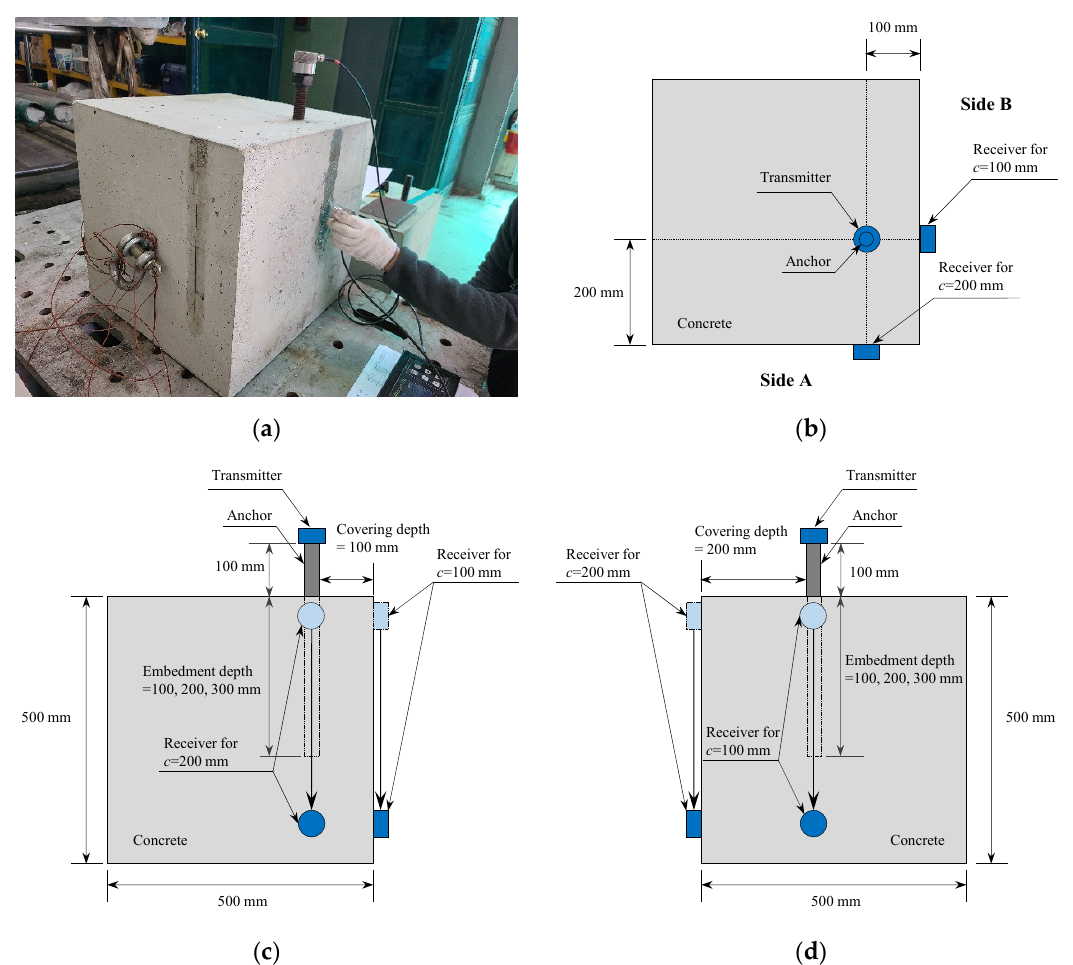
Figure 9. Details of the specimens and the location of the transducer: ( a ) test specimen; ( b ) top view; ( c ) side A; ( d ) side B.